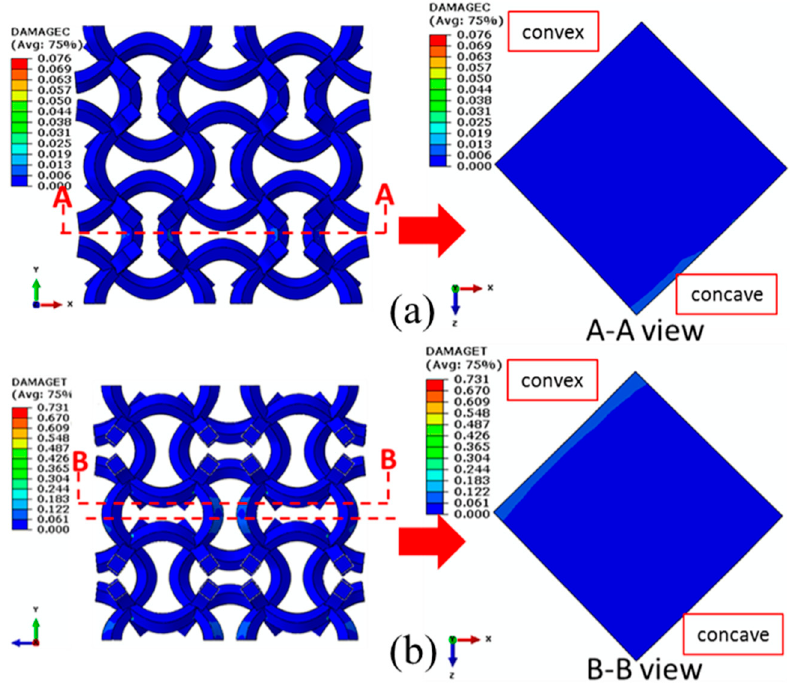
Figure 15. Damage distributions of the CCF3 under the compressive displacement of 1.65 mm (uniaxial strain of 8.25%) in the y direction: ( a ) compressive damages; ( b ) tensile damages.